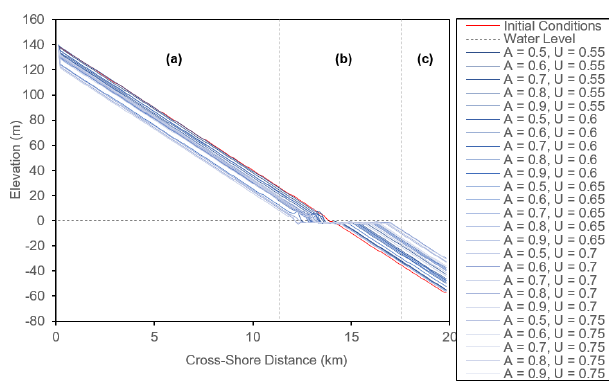
Figure 13. Cross-shore profiles taken for each of the 25 simulations, with water level shown as a dashed line and the initial cross-shore profile shown as a solid red line. Labelled are the (a) beach sur- face, (b) dynamic shoreline and upper nearshore, and (c) the lower